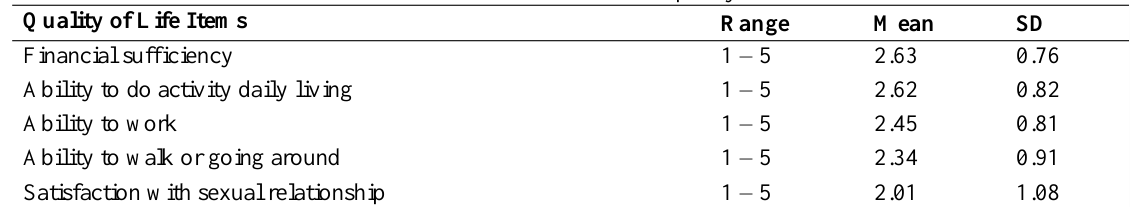
Table 6. Mean score and standard deviation of the five low items quality of